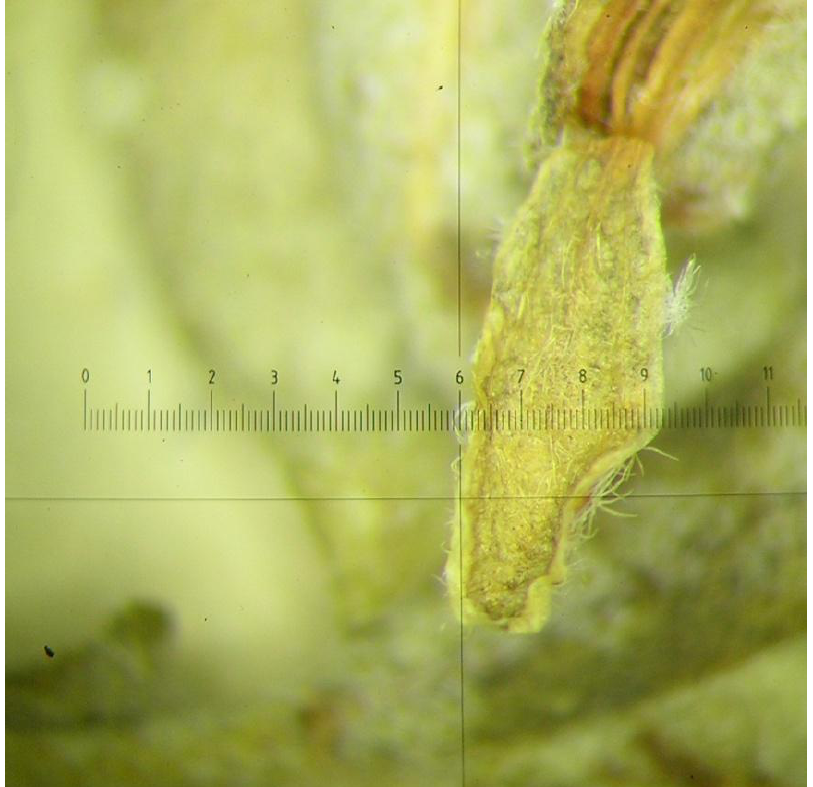
Fig. 3. Inner surface of sepal in type specimen of A. muelleri by